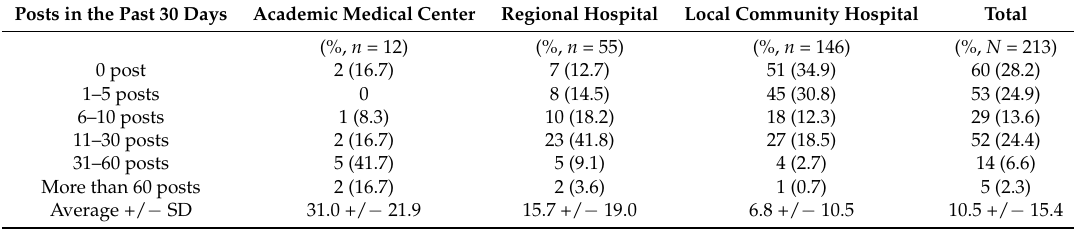
Table 3. Frequency of posts in the past 30 days on official Facebook fan pages of 213 hospitals in